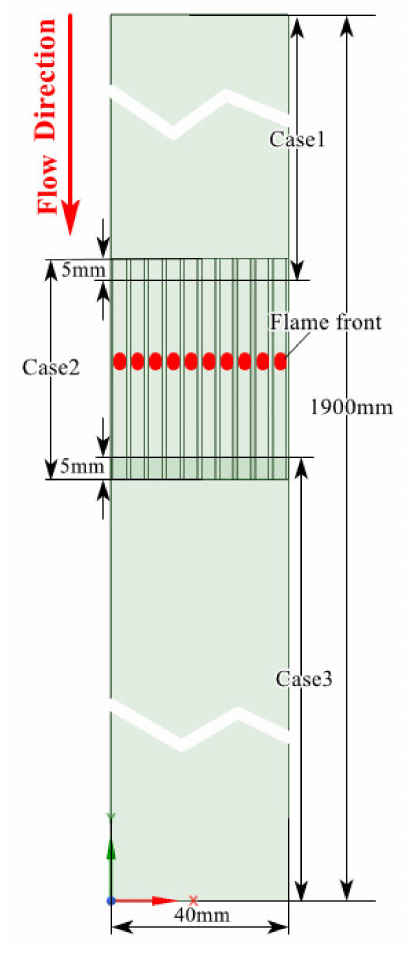
Figure 2. Schematic diagram of the multi-scale model.